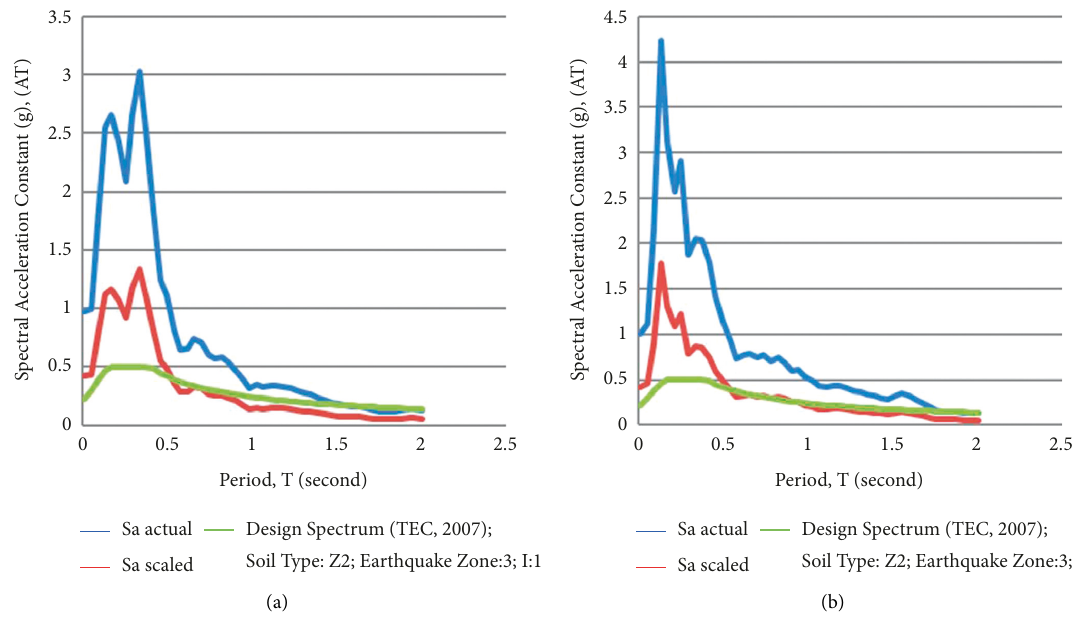
Figure 20: Evaluation of A(T) spectral acceleration constants for (a) North-South (N-S) and (b) East-West (E-W) components of earthquake with epicenter at Kayseri-Kocasinan ( M D : 3.7- M L : 3.9).